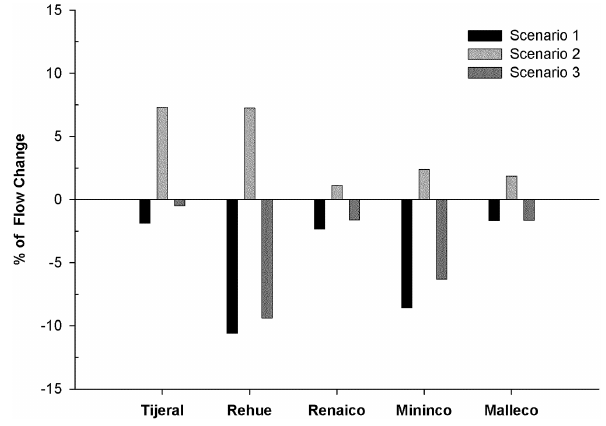
Fig. 12. Changes of mean annual discharges at Tijeral, Rehue, Re- naico, Mininco and Malleco under land use scenarios respect to the